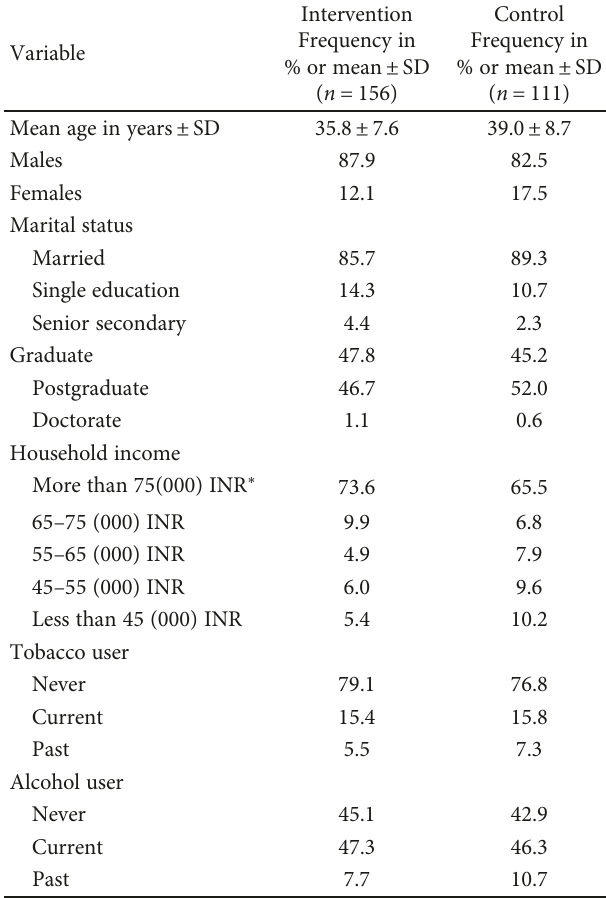
Table 1: Baseline